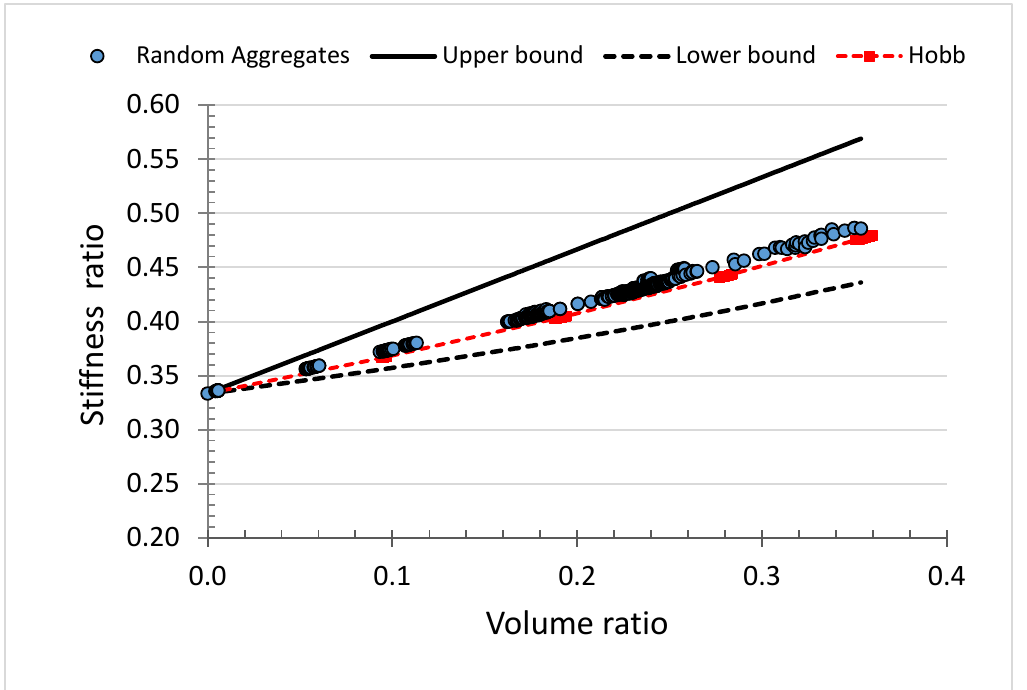
Fig. 11. Stiffness ratio of random stone aggregates compared with Hobbs